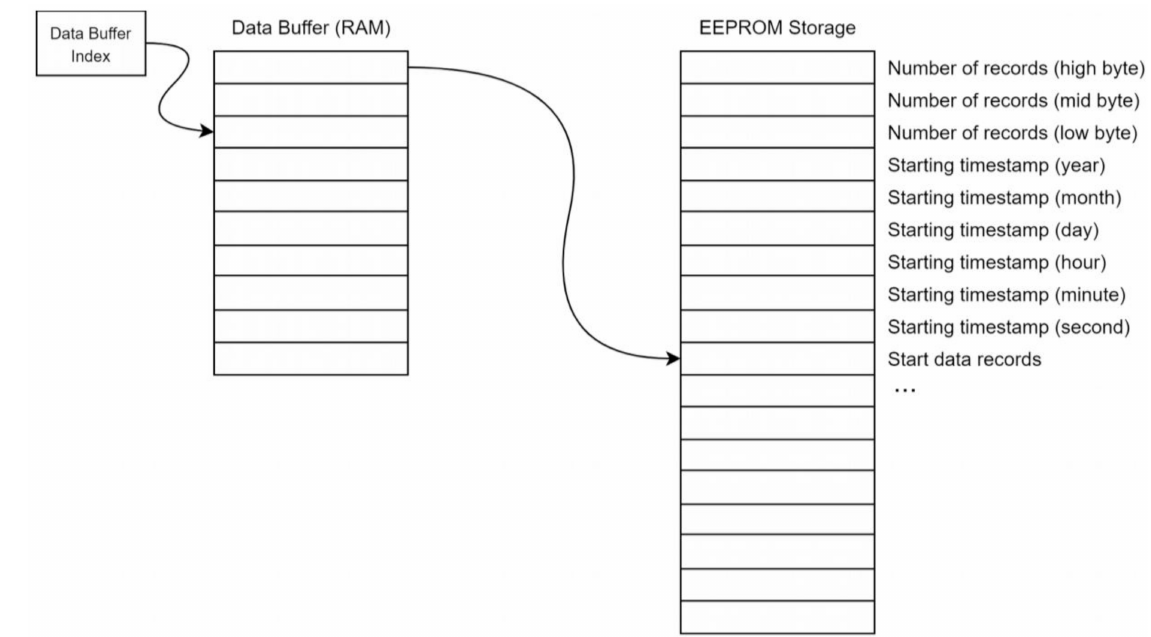
Figure 5. CIWS computational node record storage